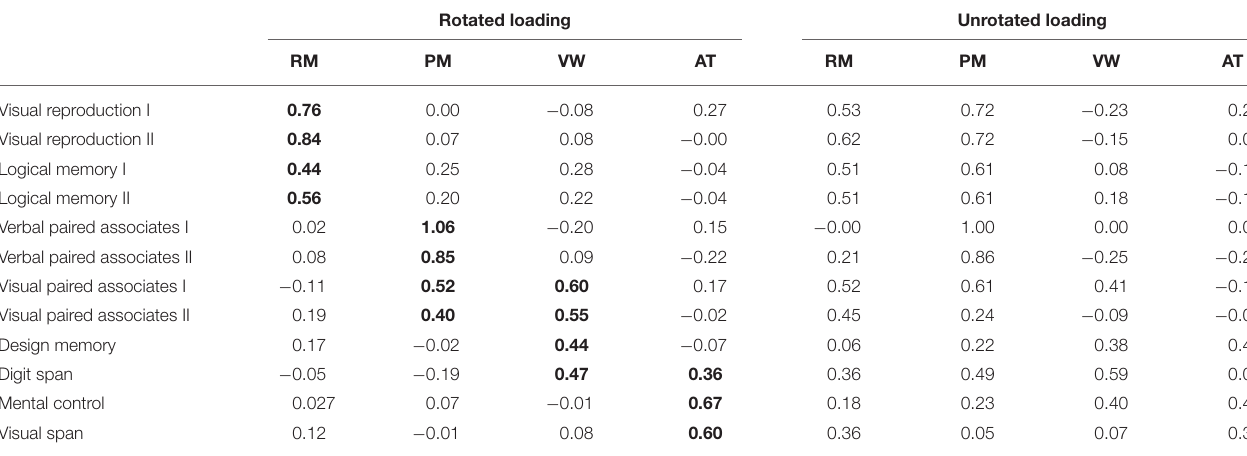
TABLE 3 | Four-Factor Promax Solution for WMS-R. Rotated loading Unrotated